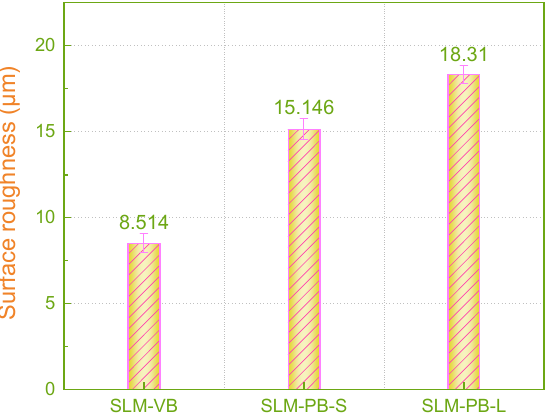
Figure 10. Surface roughness values for SLM Ti6Al4V samples.